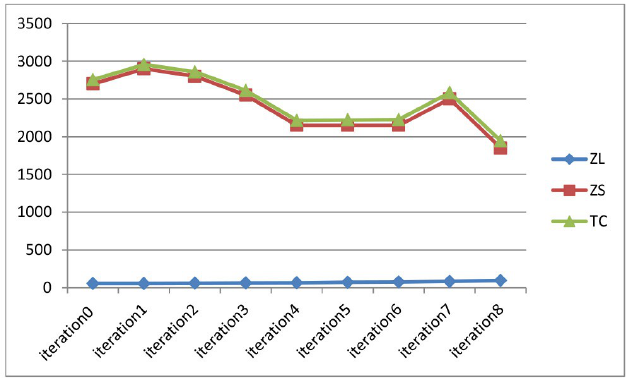
Figure 1. Total cost, Lot sizing cost (ZL) and Scheduling cost (ZS) obtained when applying the proposed